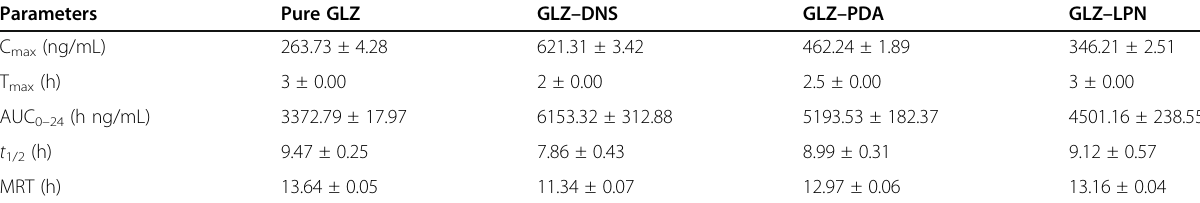
Table 4 Pharmacokinetic parameters of pure GLZ and prepared cocrystals Parameters